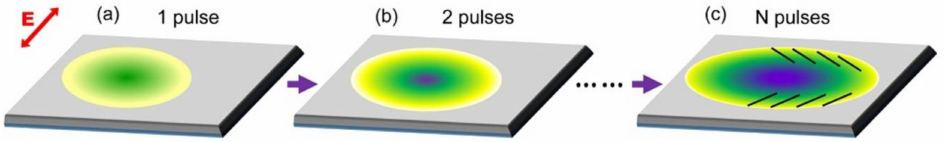
Figure 4. Schematic diagrams of the physical processes for the formation of slantwise-oriented periodic ripple structures on the metal surface. E represents the direction of the laser polarization. The different colors represent variations of the modulation depth, which tended to cause the inclined surface within the laser irradiation